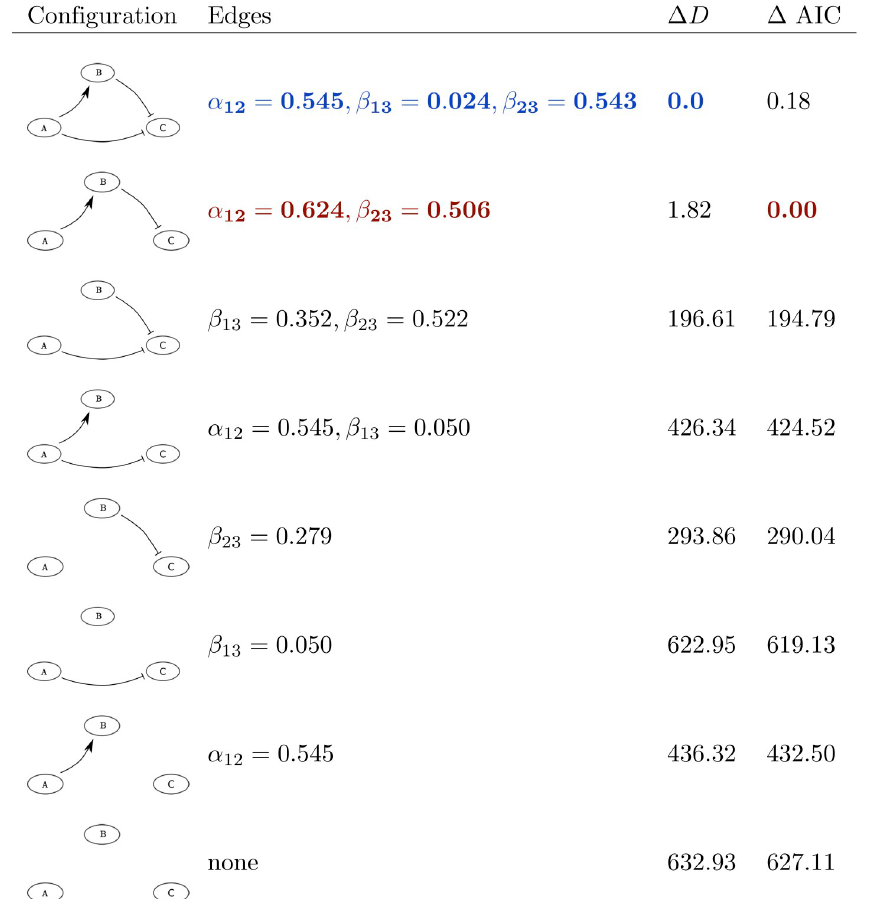
Fig 2. For each network configuration we list the model edges, the fitted edge parameter values, and the relative D and AIC when compared to their minimal found values, with D ¼ min (cid:0) 2 log ð L ð θ ÞÞ , L ð θ Þ the likelihood θ function defined in Eq (3), and AIC defined in Eq (4). Whilst the three edge network (in blue) has the smallest relative D , the AIC selects the two edge network that was used to generate the synthetic dataset (in red). The edge parameter values used to generate this synthetic dataset are α 12 = β 23 = 0.5 and β 13 =